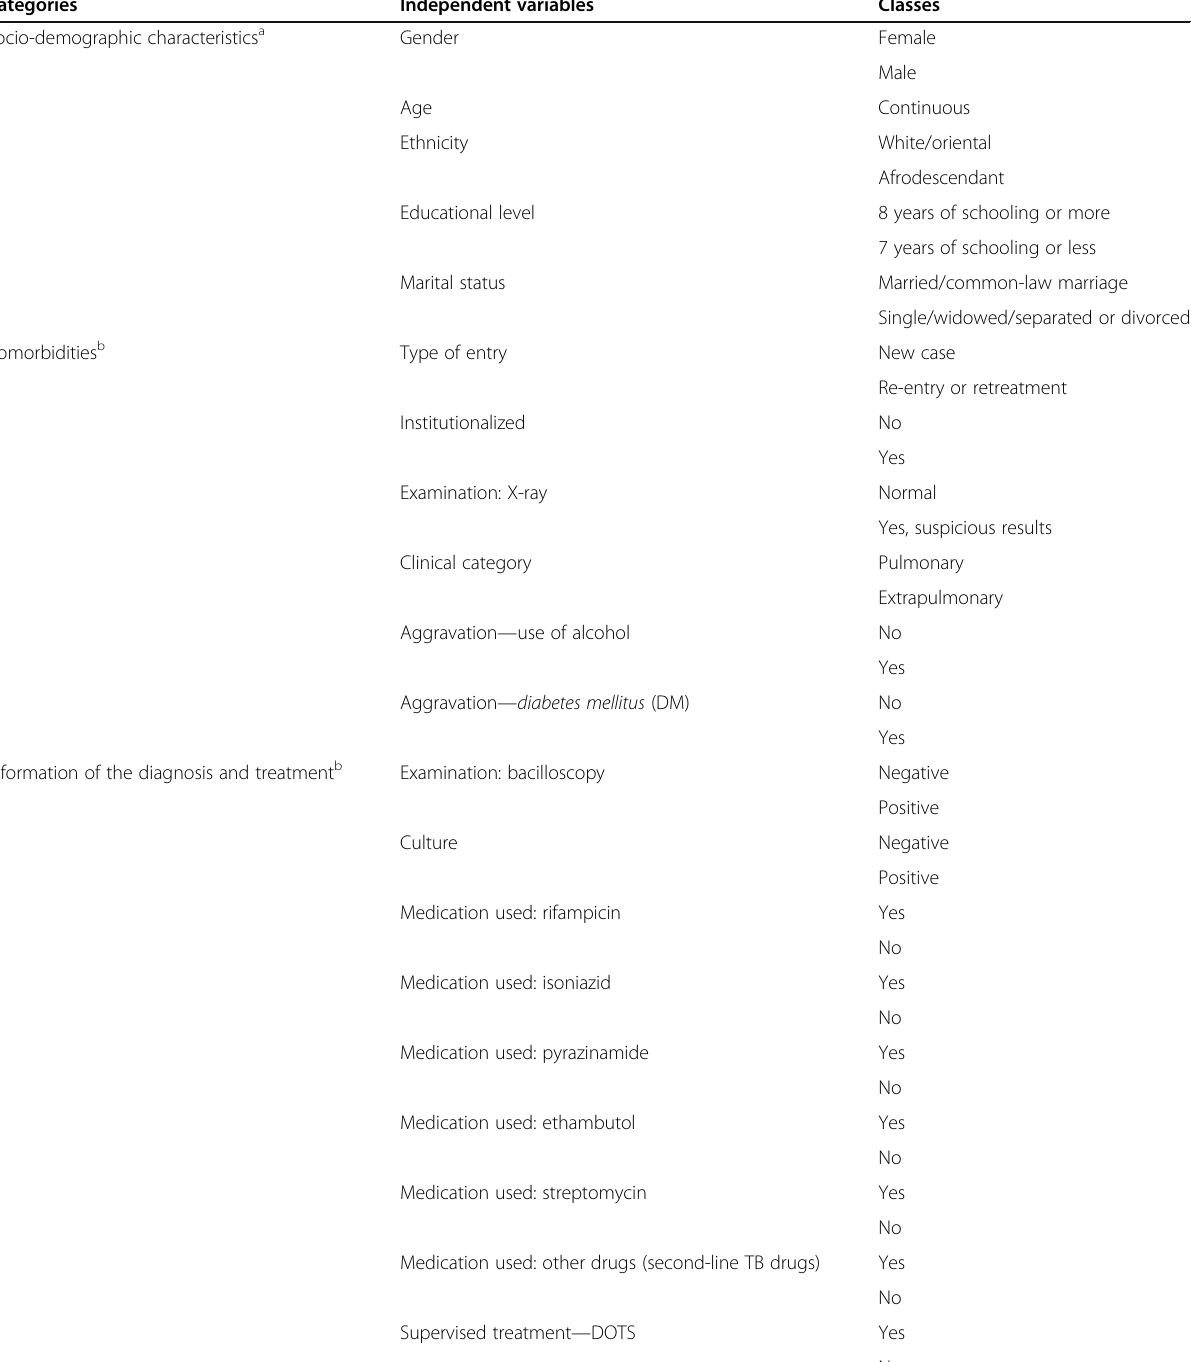
Table 1 Independent variables under study